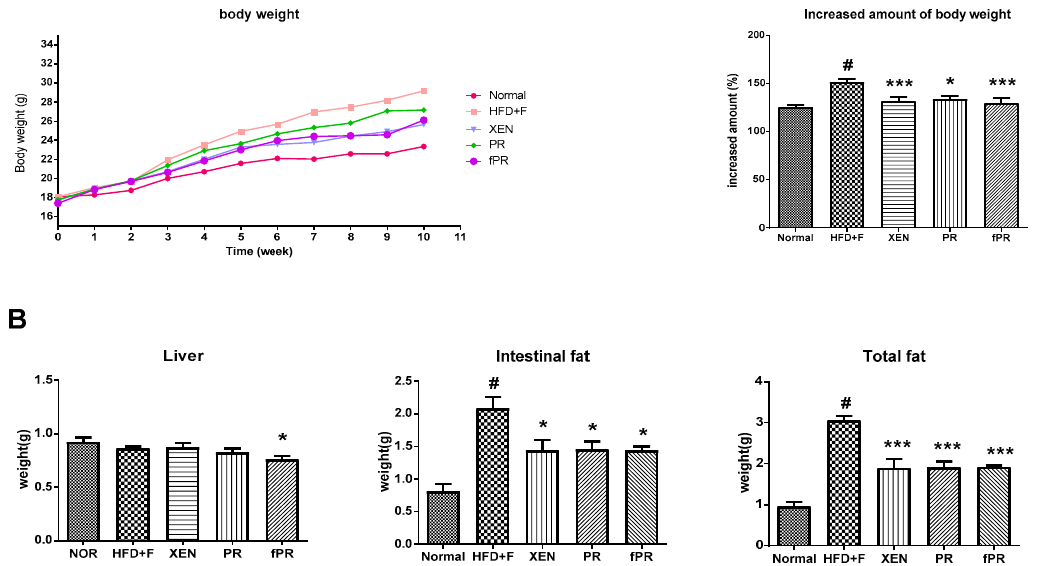
Figure 2. E ff ects of Puerariae Radix (PR) and fermented Puerariae Radix (fPR) on body weight gain, liver weight, and intestinal and total fat weights of normal and high-fat diet plus fructose (HFD + F)-fed mice during the 10 week study period: ( A ) body weight and ( B ) tissue weights as indicated. Bodyweight was recorded every week. Tissue weights were recorded at sacrifice. Data are expressed as means ± SD; di ff erences were evaluated by using one-way ANOVA. # p < 0.05 compared to the normal group; * p < 0.05, *** p < 0.001 compared to the HFD + F group.